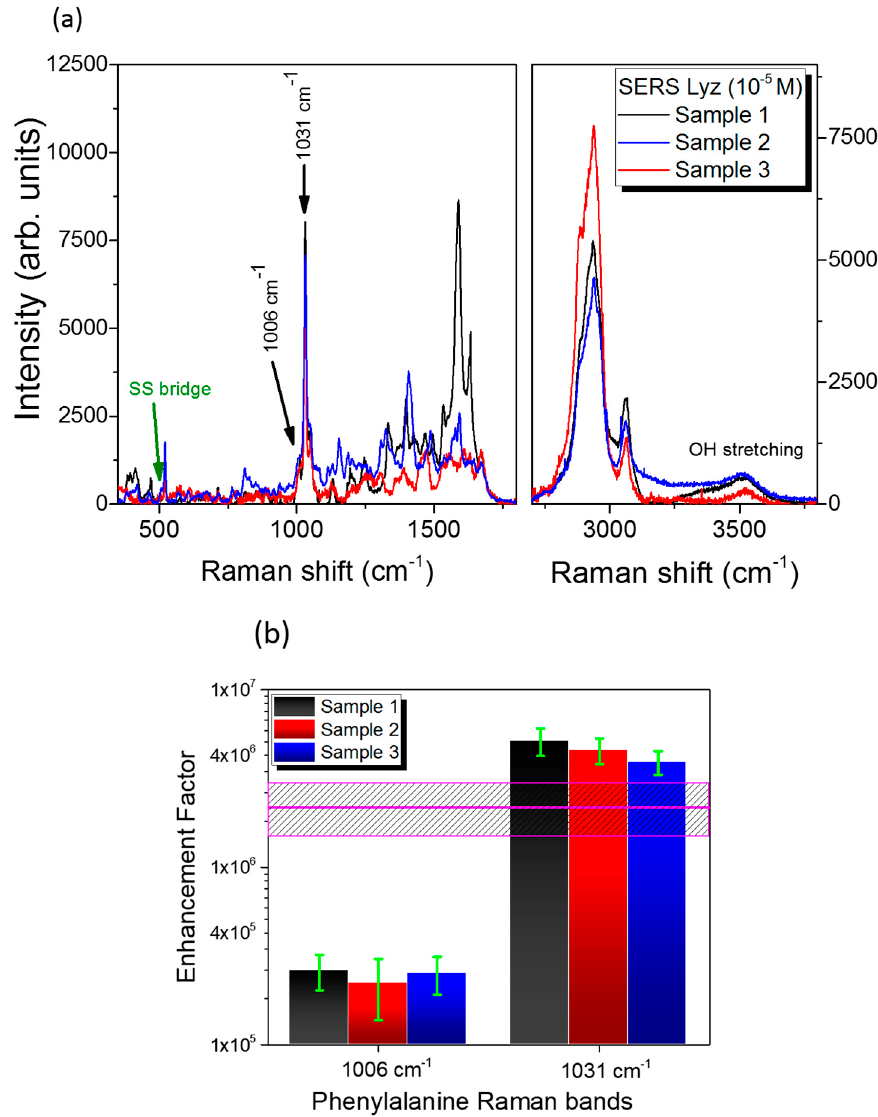
Figure 6. SERS signal from lysozyme target protein (Lyz) hydration region. ( a ) SERS spectra of lysozyme (10 − 5 M) measured on three different samples, as representative for the ensemble of measurements, presented in the low and high frequency regions. ( b ) Enhancement factors measured on the three spectra reported in ( a ) for the phenylalanine (Phe) peaks at 1006 and 1031 cm − 1 . The magenta line and dashed rectangle indicate the enhancement factors (EFs) calculated average value. For all the SERS spectra in ( a ), we used the same 100× microscope objective with an integration time of 30 s and a laser power of 45 μ W.